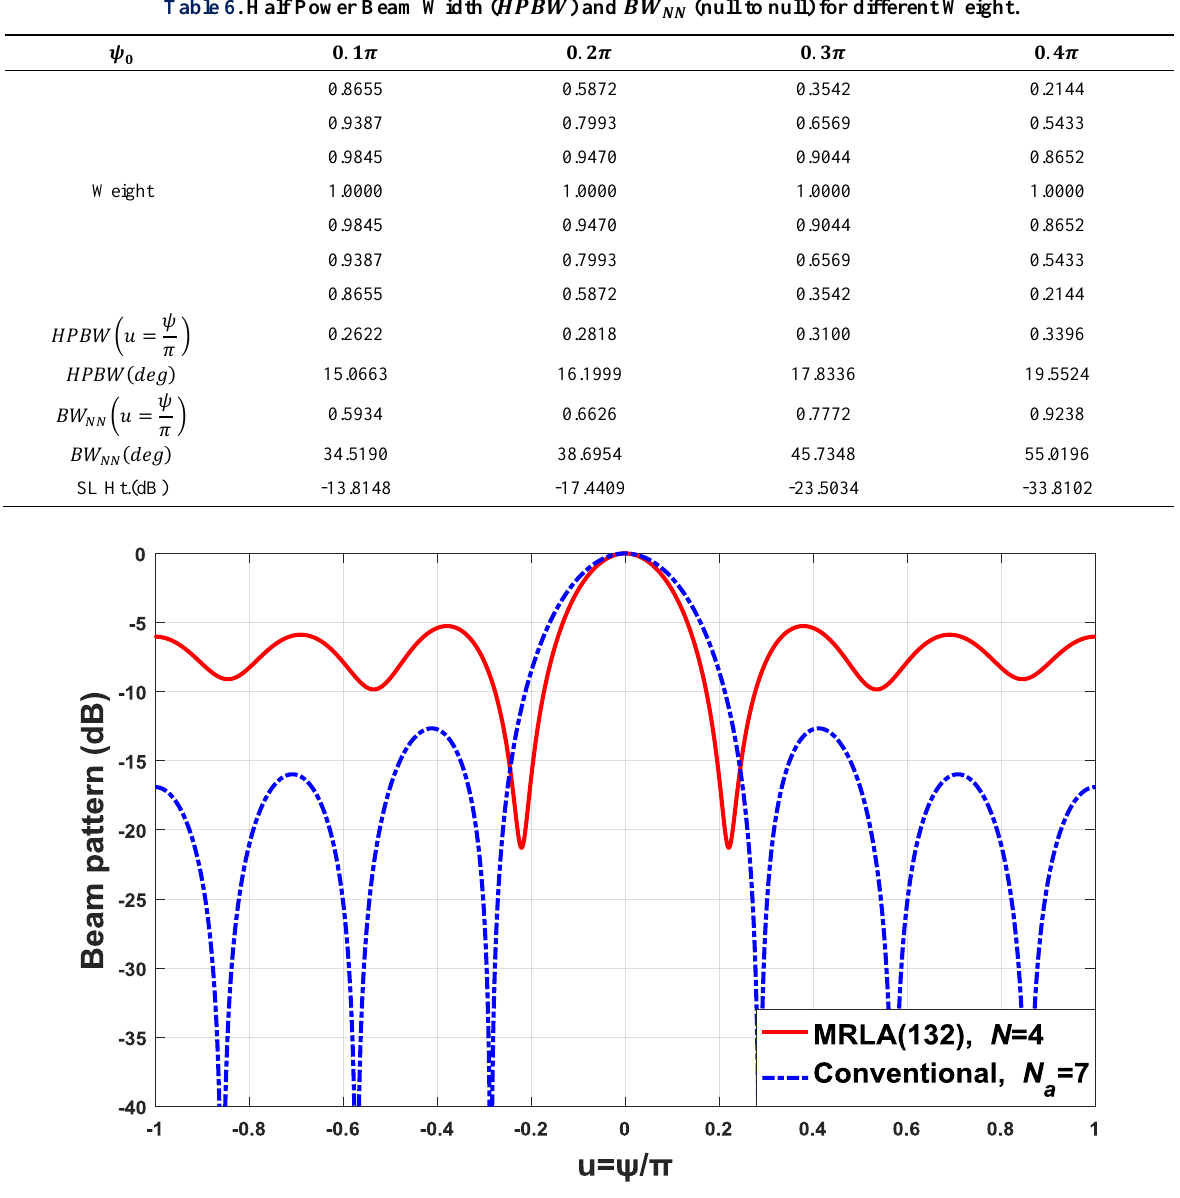
Figure 6. Beam pattern of a uniformly weighted 4-element MRLAs and Conventional (ULAs). Table 7. Minimum redundancy arrays HPBW, BW and 𝑩𝑾 𝑵𝑵 null-to null for Non-Uniform and Uniform 4 –element